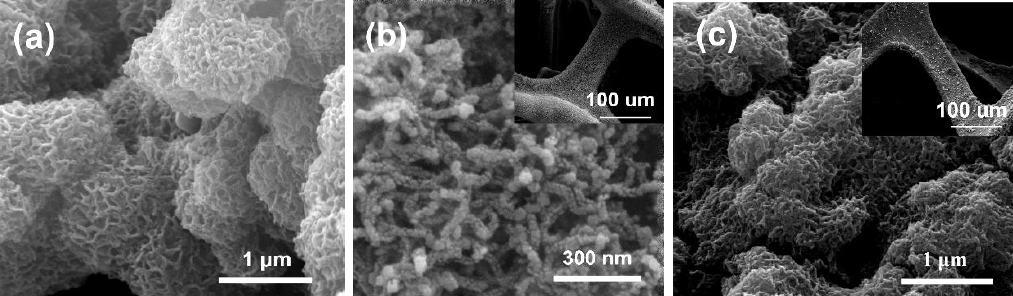
Figure 1. SEM images of ( a ) CoSe/NF, ( b ) Co 3 O 4 -CNTs/NF and ( c ) CoSe/Co 3 O 4 -CNTs/NF.